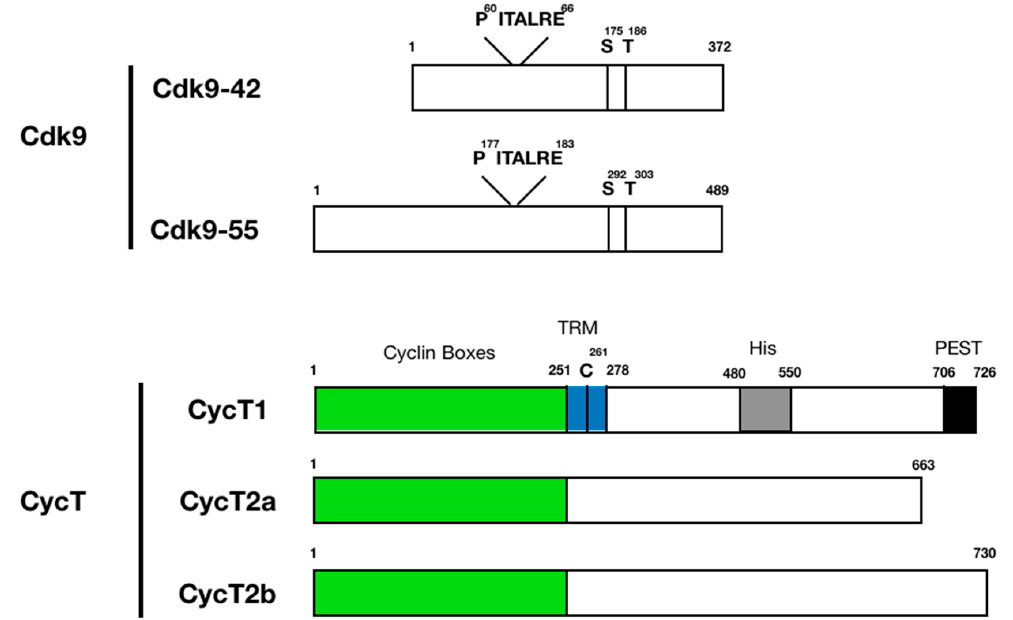
Figure 1. Schematic presentation of Cdk9 and CycT domain structures. There are two isoforms of Cdk9 (Cdk9-42 and Cdk9-55). These two proteins are identical except that CDK9-55 has a longer N-terminal region. Cdk9 contains a unique self-inhibitory sequence (PITALRE) and phosphorylation sites. CycT1, T2a, and T2b (collectively, CycT) contain two highly conservative cyclin box structures in their N-termini, which interact with CDK9 (green). In CycT1, a region immediately after the cyclin boxes (a.a. 251–278) interacts with HIV Tat and TAR via a critical C261 residue, and hence is called the Tat-TAR recognition motif (TRM) (blue). CycT1 contains a region rich in histidine residues (a.a. 480–550) that is required for direct interaction with RNAPII CTD (gray). The C-terminal end (a.a. 706–726) of CycT1 forms a typical PEST motif, which determines its protein stability in cells